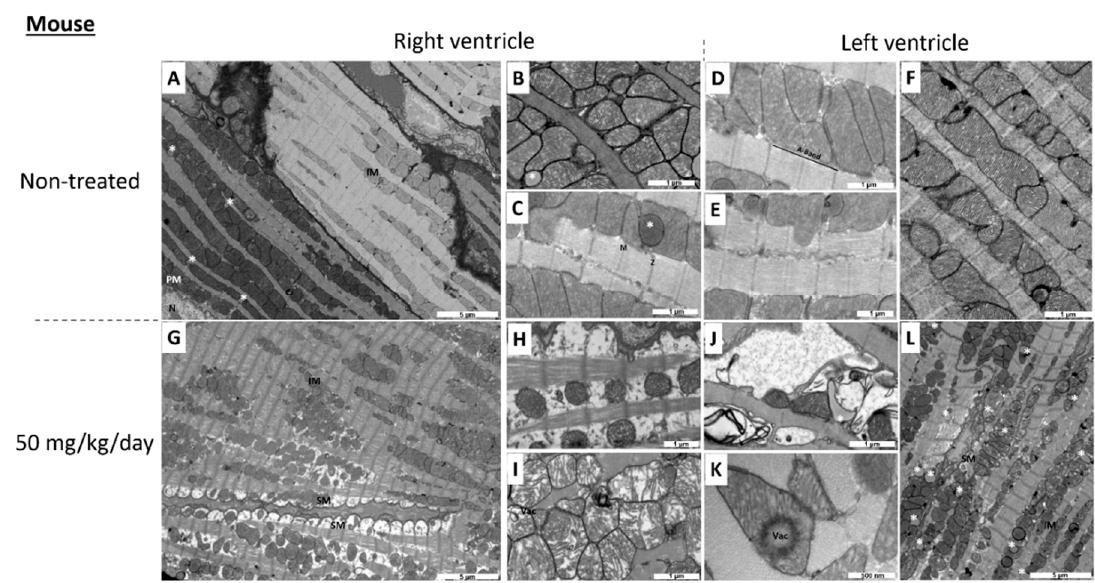
Figure 2. Transmission electron micrograph of non-treated ( A – F ) and 50 mg I-BET-151/kg/day treated ( G – L ) mouse right ventricle ( A – C , G – I ) and left ventricle ( D – F , J – L ). SM indicates sub-sarcolemmal mitochondria; IM, interfibrillar mitochondria; PM, perinuclear mitochondria, Vac, vacuole; N, nucleus; M, M line; Z, Z line. Asterisks indicate lipid droplets. Bar scale is indicated on each micrograph. Selection of the most representative pictures from three animals per group.